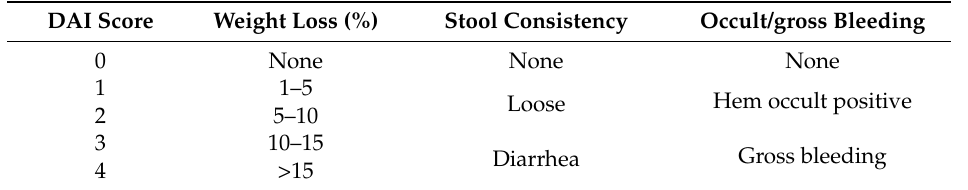
Table 2. Evaluation of disease activity index (DAI) scores.